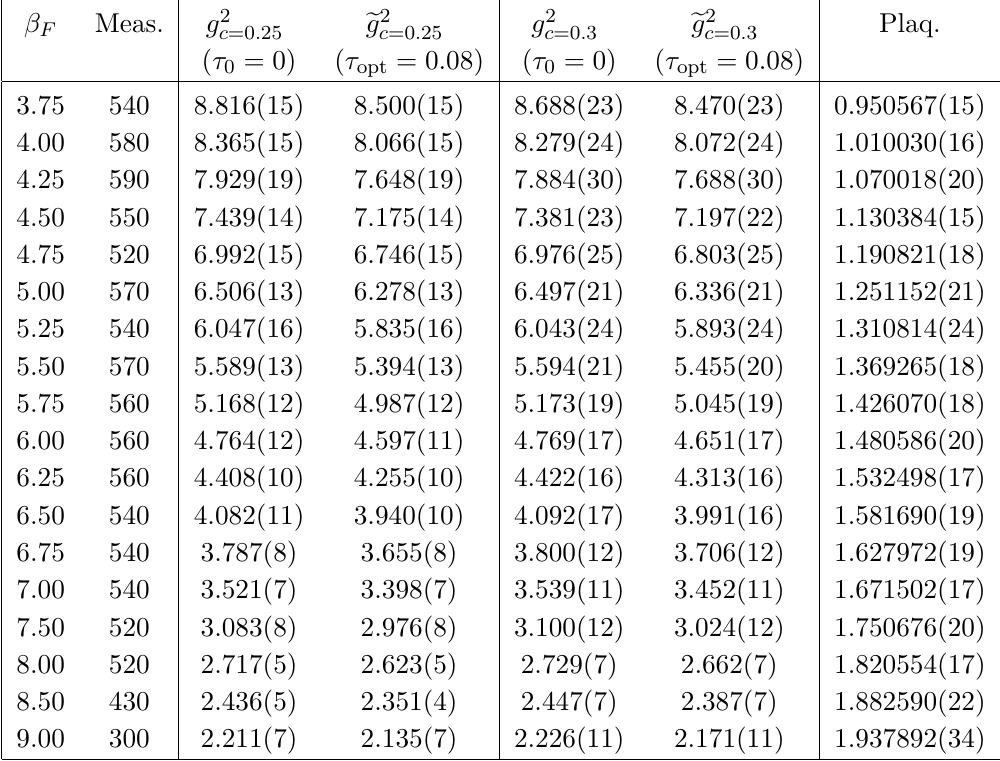
Table 7 . 24 4 lattice ensembles used in this work, with columns as in table 3.